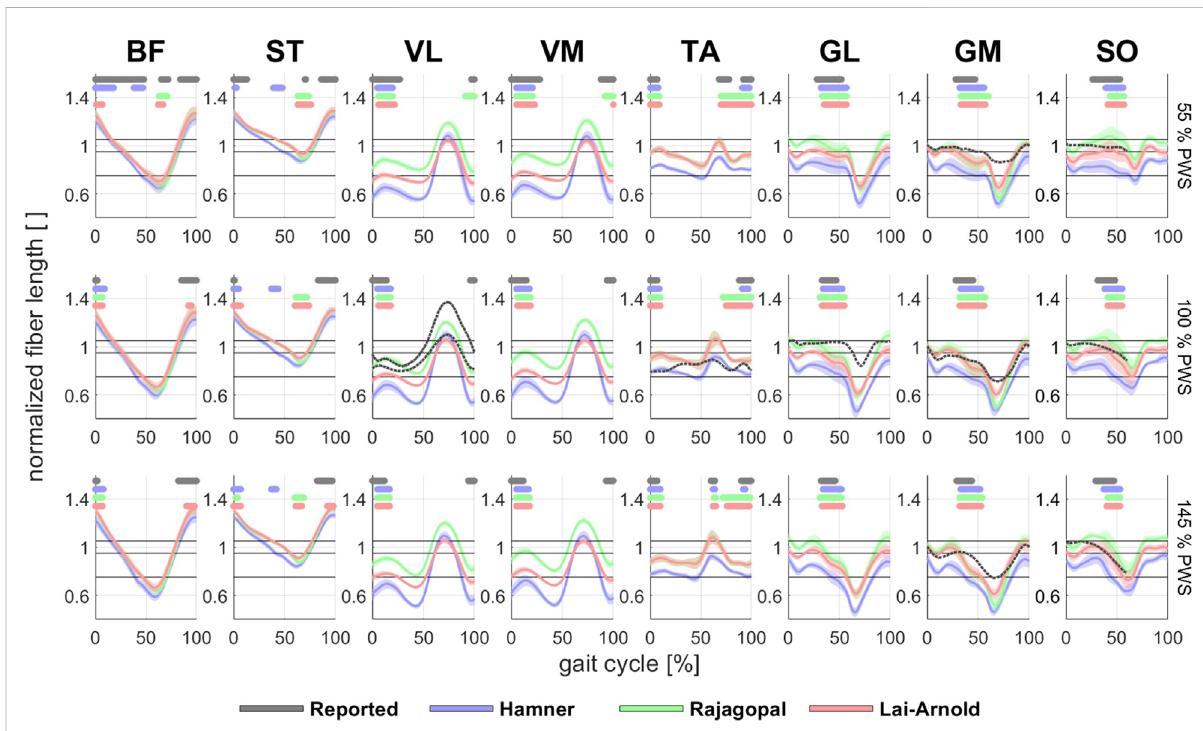
FIGURE 6 Estimated normalized fi ber length (average +/- 1 SD of all subjects)in 8 muscles with performance criterion J2 and scaling variant S1 at walking speeds of 55%, 100% and 145% PWS. Reported experimental normalized fi ber lengths of SO (Lai et al., 2015), GM (Farris and Sawicki, 2012), GL (Farris and Raiteri, 2017), and VL (Chleboun et al., 2007; Bohm et al., 2018) are shown. Experimental fi ber lengths were normalized based on average values reported from a muscle architecture data set (Ward et al., 2009) if experimental studies did not provide normalized values. Horizontal lines above time series indicate on/off timing for EMG and each model. Dashed horizontal lines indicate operating ranges between steep and shallow ascending limb (lower), shallow ascending limb and plateau (middle), and plateau and descending limb